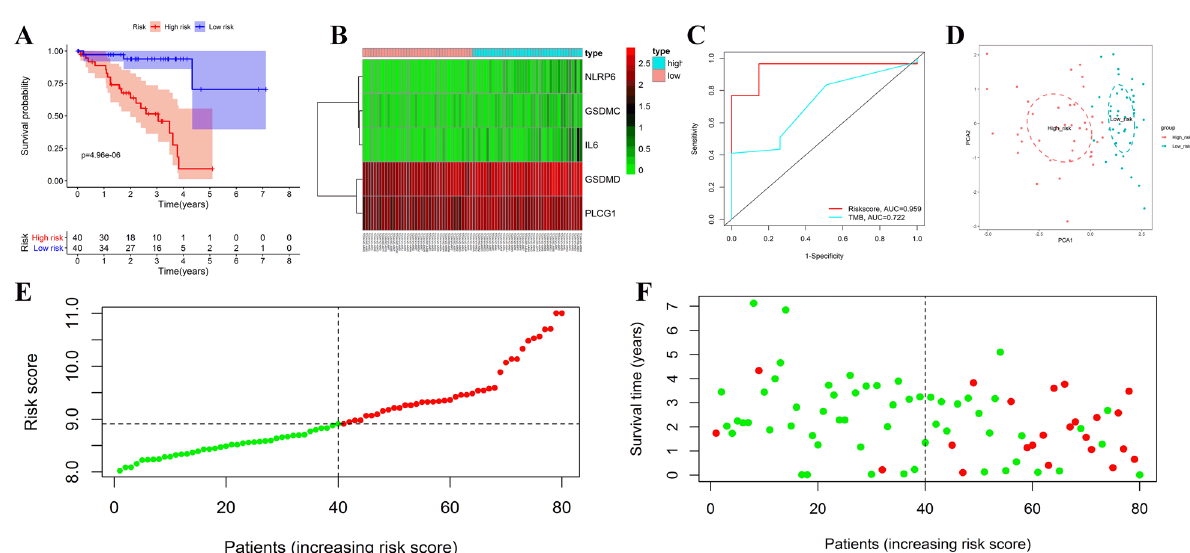
Figure 2. Validation of the prognostic signature in the training group. Kaplan–Meier (KM) curve compares the overall survival between low- and high-risk groups ( A ). Heatmap of differentially expressed pyroptosis-related genes ( B ). Time-dependent ROC curves of the risk score and TMB ( C ). PCA plot based on the risk score; The red dots represent high-risk patients, whereas the blue dots represent low-risk patients ( D ). Distribution of risk scores between low- and high-risk groups; The red dots represent high-risk patients, whereas the green dots represent low-risk patients ( E ). Survival status of UM patients in the low- and high-risk groups; The red dots represent deaths, whereas the green dots represent survivals ( F ). The figure was performed using R software (version 3.3.1, Vienna, Austria, https:// www.r- proje ct.